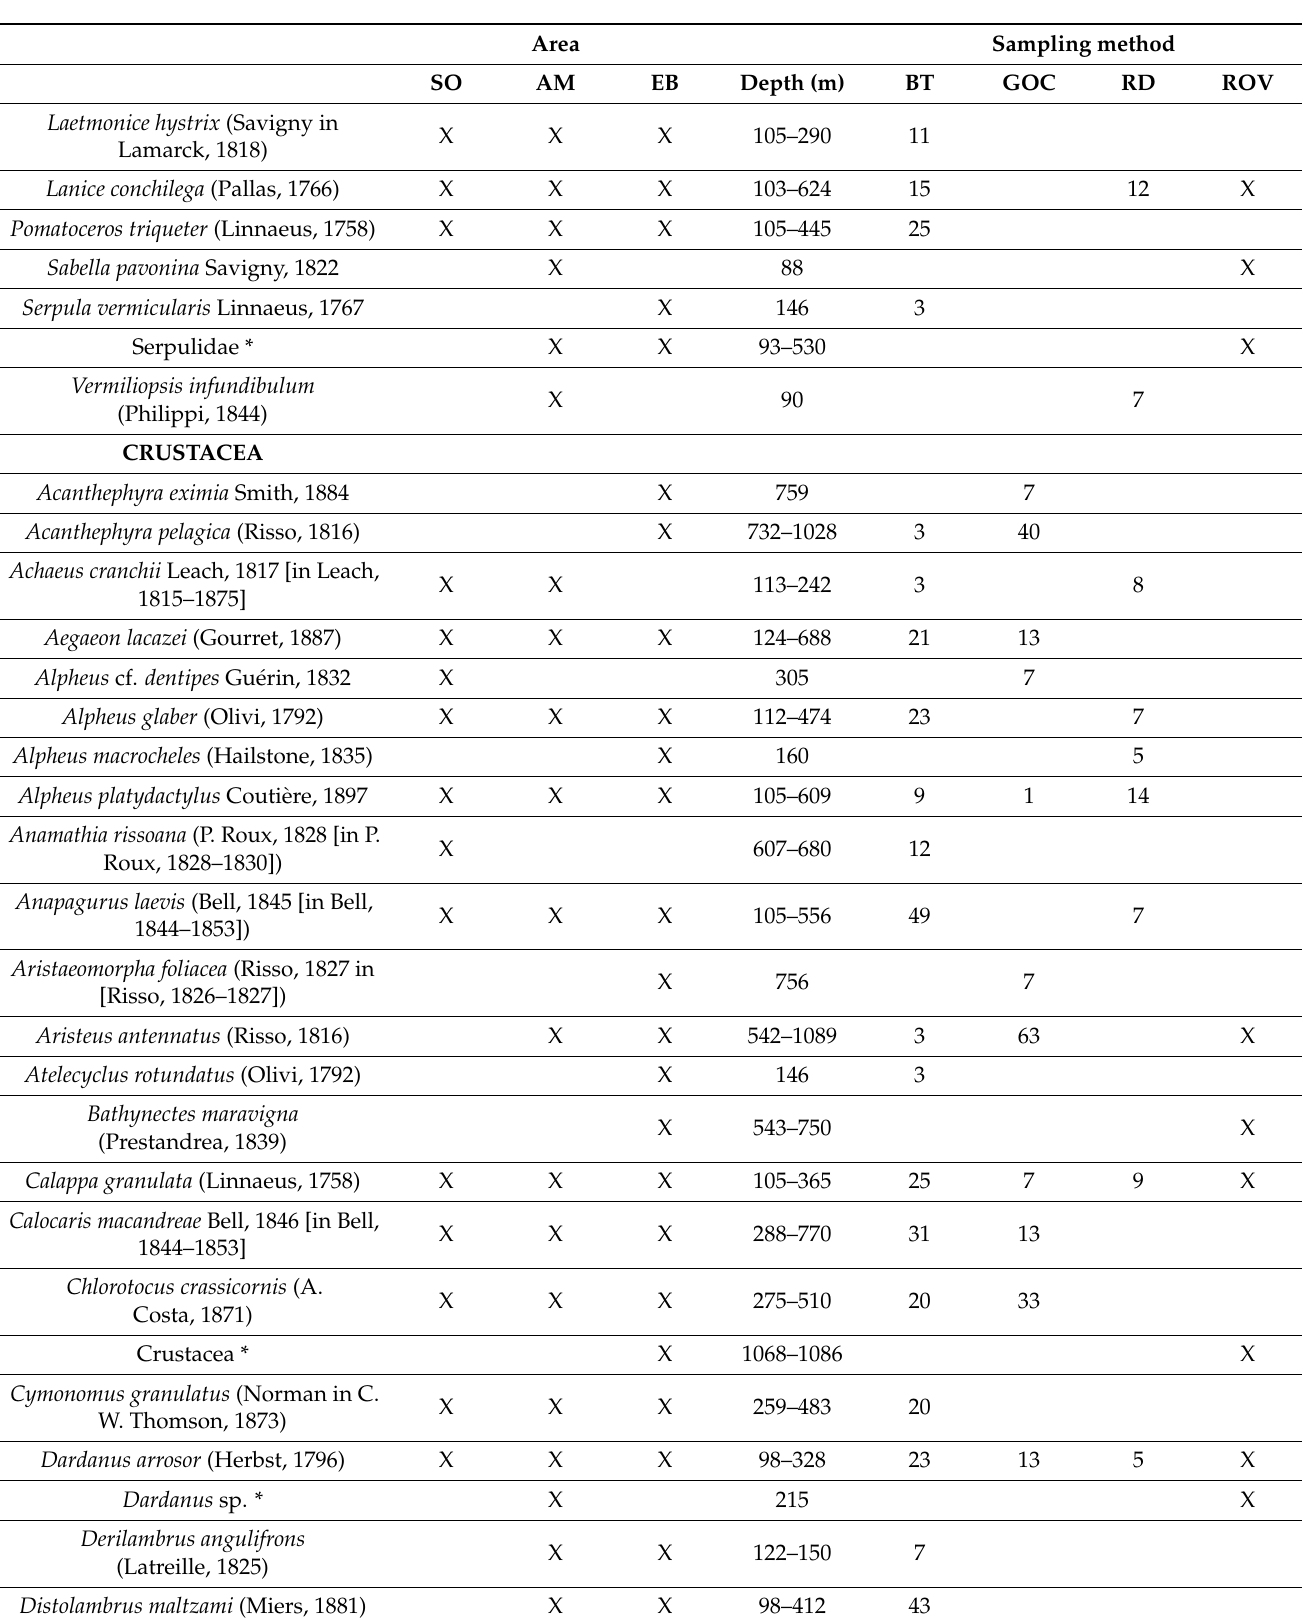
Table A7. Cont. Area Sampling